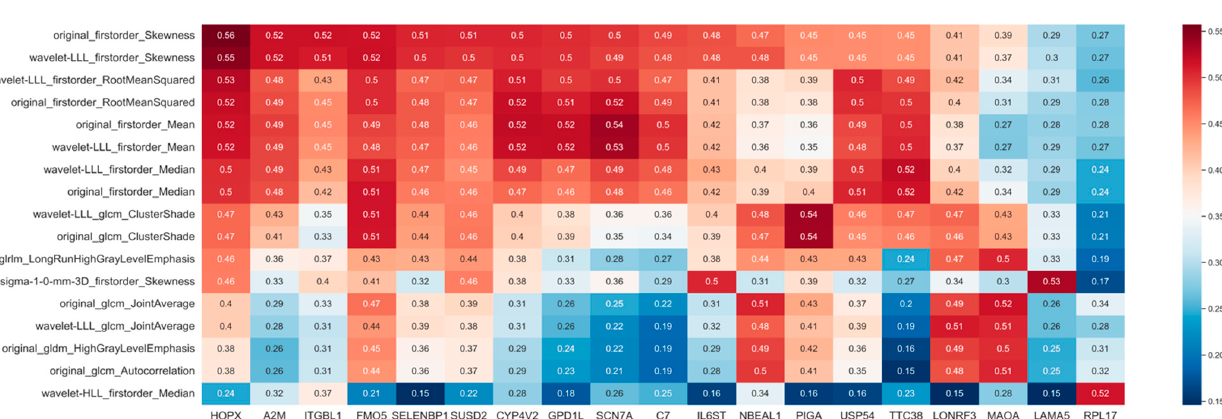
Figure 4. Correlation coefficient (absolute value) heatmap between gene expression (HOPX) and image features. Red color refers to high correlations.